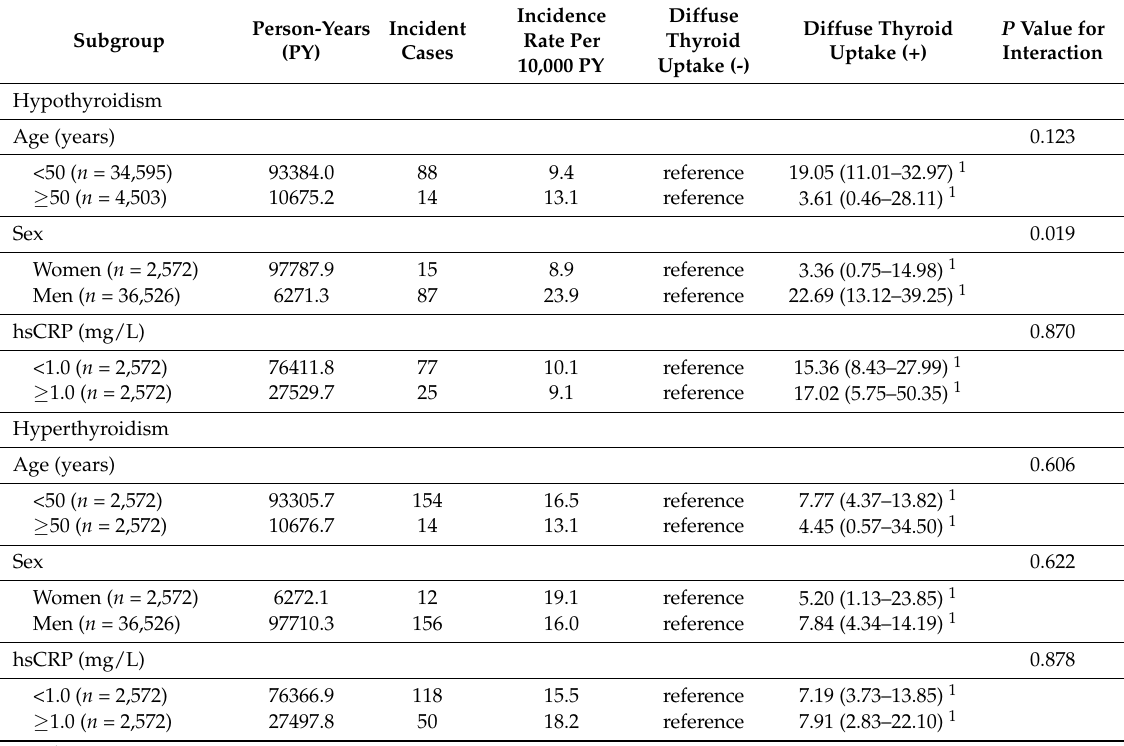
Table A1. Development of thyroid dysfunction according to thyroid uptake on PET-CT by